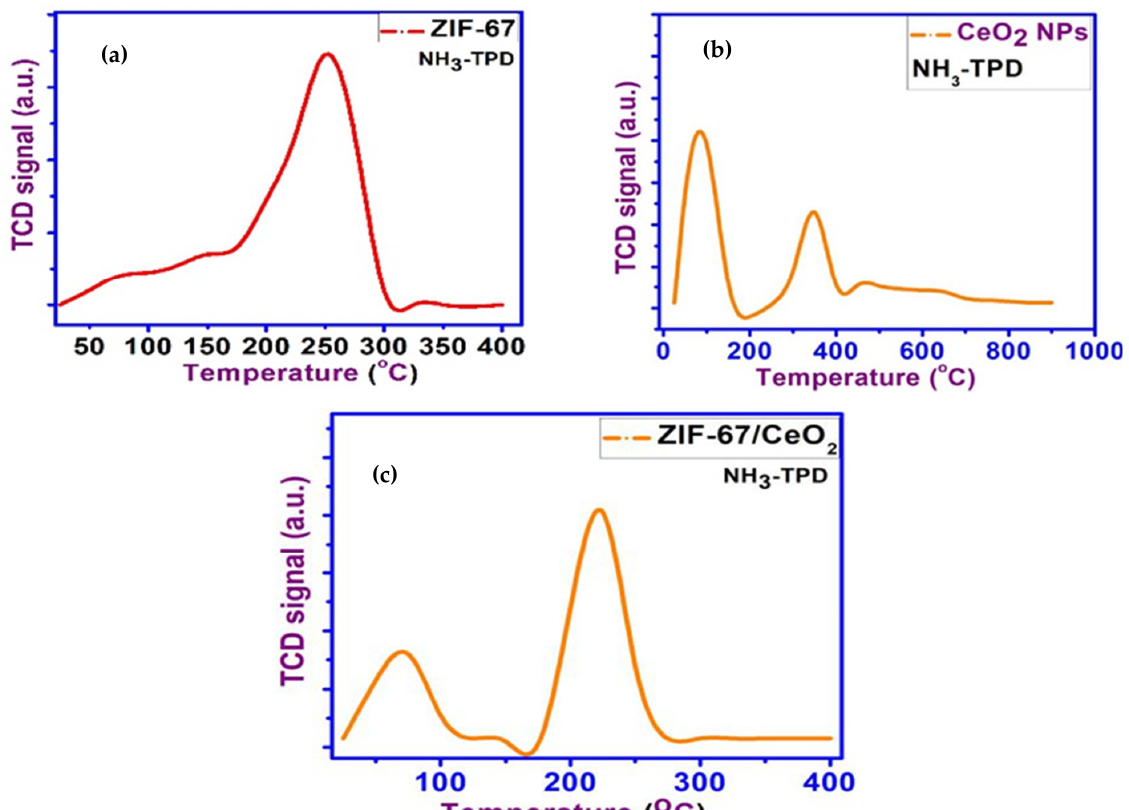
Figure 6. N 2 adsorption–desorption isotherms of ( a ) Pure CeO 2 , and ( b ) ZIF-67.